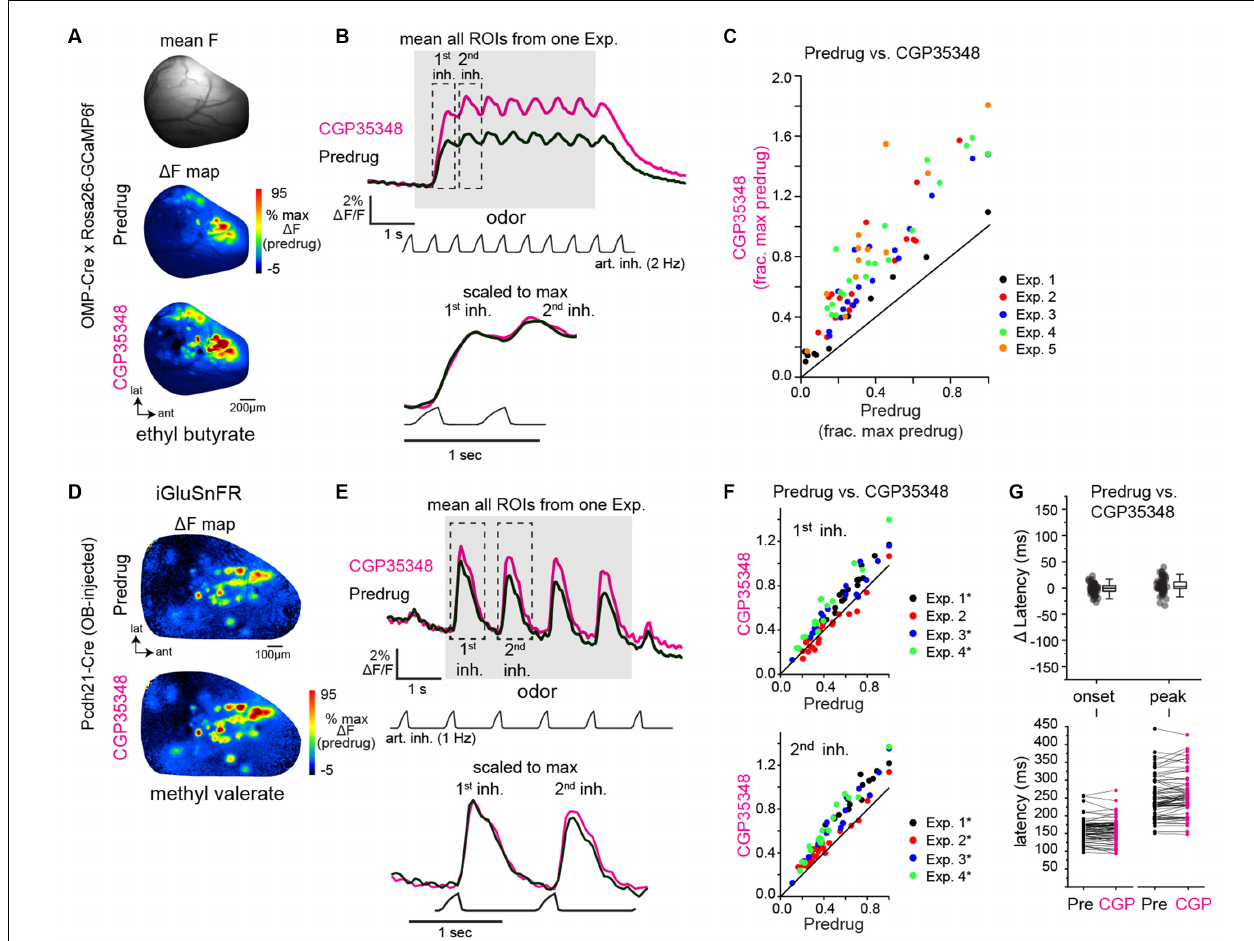
FIGURE 1 | GABA B -mediated presynaptic inhibition regulates the strength, but not the timing, of inhalation-driven glutamatergic signaling onto mitral/tufted cells. (A) Baseline fluorescence (mean F) and ∆ F maps (OMP-Cre × Rosa26-GCaMP6f) of calcium responses to methyl valerate before (Predrug) and after application of CGP35348. (B) Traces showing mean fluorescence of all glomerular regions of interest (ROIs) in one olfactory bulb (OB) to the odorant presentation (ethyl butyrate) before and after application of CGP35348. Trace showing artificial inhalation pressure is below the response traces (2 Hz). Lower traces show expansion of responses to the first and second inhalation of odorant scaled to the same maximum. (C) Peak OSN—GCaMP6f responses ( ∆ F/F) in each measured ROI, normalized to the maximal predrug response in each experiment. Each color is an individual experiment. Summary statistics for each experiment (median CGP35348/Predrug ratio, Wilcoxon Signed Ranks Test, p-value corrected for multiple comparisons): Exp. 1: 1.60, Z = − 2.89, p = 0.004, Exp. 2: 1.91, Z = − 3.60, p = 3.21 × 10 − 4 , Exp 3: 1.76, Z = − 3.70, p = 2.14 × 10 − 4 , Exp. 4: 2.13, Z = − 3.80, p = 1.43 × 10 − 4 , Exp. 5: 2.46, Z = − 3.02, p = 0.003. (D) Odorant-evoked ∆ F maps showing glutamate signals (SF-iGluSnFR.A184V) on MT cells before and after CGP35348 application. (E) Mean iGluSnFR fluorescence across all glomerular regions of interest (ROIs) in one olfactory bulb (OB) to the odorant presentation (ethyl butyrate) before and after CGP35348 application. Odorant was delivered using 1 Hz artificial inhalation. Bottom traces show expanded responses to the first two inhalations of odorant, scaled to the peak of the first inhalation response. (F) Peak MT Cell—iGluSnFR ∆ F/F responses ( ∆ F/F) in each measured ROI before and after CGP35348 application, normalized to the maximal Predrug response in each experiment. Summary statistics, reported as in (C) : CGP35348/Predrug (first inhal.; mean ± SD): Exp. 1: 1.2 ± 0.06, n = 19, p = 2.9 × 10 − 10 ; Exp. 2: 0.97 ± 0.17, p = 1.0, n = 20; Exp. 3: 1.24 ± 0.15, n = 16, p = 2.6 × 10 − 5 ; Exp 4: 1.4 ± 0.2, n = 14, p = 2.5 × 10 − 5 . CGP35348/Predrug (second inhal): Exp. 1: 1.34 ± 0.11, p = 3.0 × 10 − 10 , Exp 2: 1.15 ± 0.14, p = 3.9 × 10 − 4 , Exp 3: 1.34 ± 0.20, p = 1.7 × 10 − 5 , Exp 4: 1.48 ± 0.13, p = 2.1 × 10 − 8 . Asterisks indicate Experiments with p < 0.05 after correction for multiple comparisons). (G) Change in onset and peak latencies of iGluSnFR response to the first inhalation of odorant after application of CGP35348. Same mice and glomeruli as in (E,F) . Each point is an ROI. Top: Change in latencies relative to predrug values. Boxes indicate 25th and 75th percentiles, line indicates median, whiskers denote outliers with a coefficient of 1.5. Bottom: Absolute latencies relative to inhalation start, before and after CGP35348. CGP35348 had little to no effect on the onset and peak latencies of response to first inhalation (Wilcoxon signed ranks test, medians and p-values per experiment): ∆ onset latencies, Exp. 1: − 6.3 ms, p = 0.04; Exp. 2: 3.5 ms, p = 0.2; Exp. 3: − 3.1 ms, p = 0.016; Exp. 4: 4.9 ms, p = 0.16. ∆ peak latencies, Exp 1: 3.3 ms, p = 0.16; Exp. 2: 8.4 ms, p = 8 × 10 − 4 ; Exp. 3: − 2 ms, p = 0.32 ; Exp. 4: 2.8 ms, p =